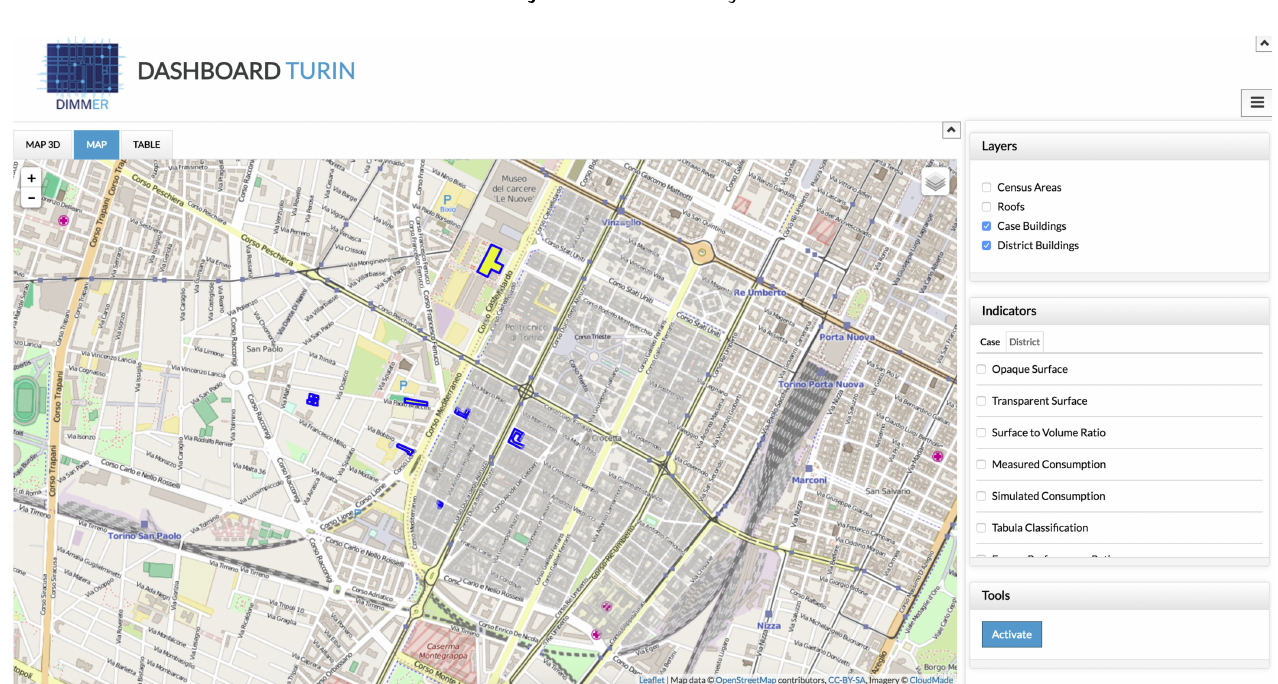
Figure 7. WebGIS